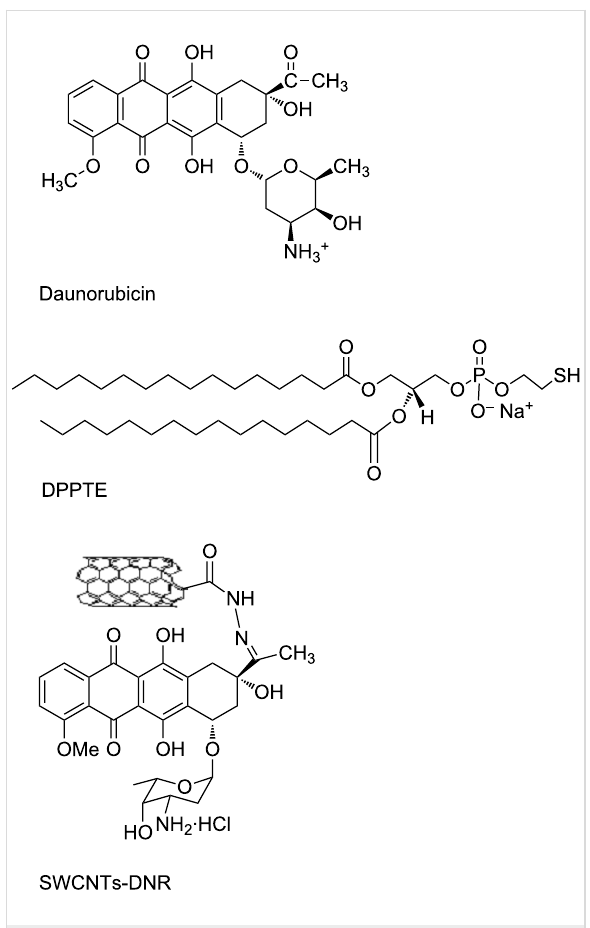
Figure 1: Structures of daunorubicin (DNR) and 1,2-dipalmitoyl- sn - glycero-3-phosphothioethanol (DPPTE) used as a component of model membranes and single-walled carbon nanotubes modified with daunorubicin